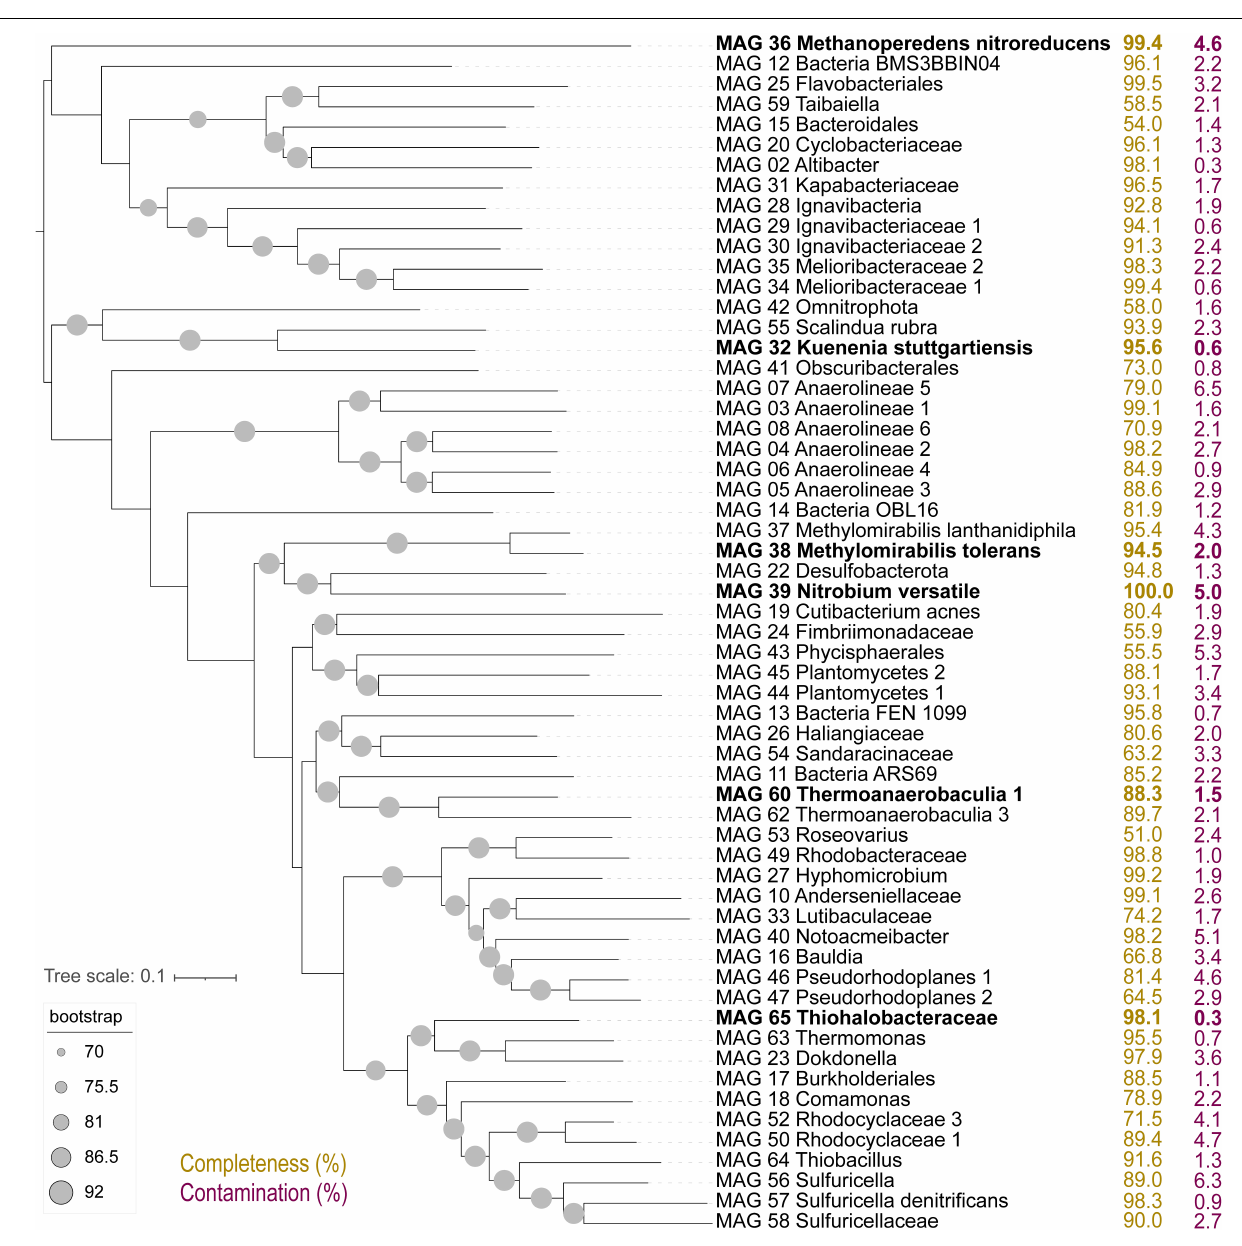
FIGURE 2 | Up-to-date bacterial core gene (UBCG) tree of 92 concatenated genes extracted from high- and medium-quality metagenome-assembled genomes (MAGs) in this study. Genome completeness (in yellow) and contamination (in purple) values in percent are indicated to the right. MAGs in bold were selected from detailed characterization due to large shifts in abundance across